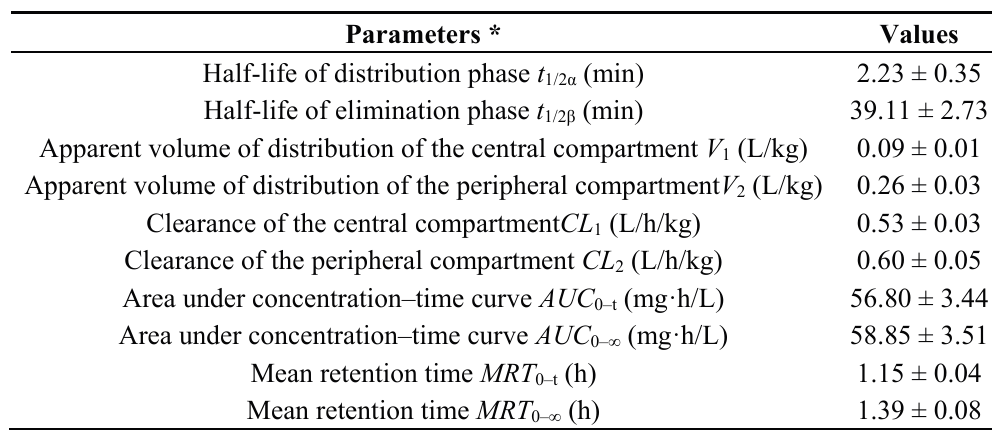
Table 3. Pharmacokinetics parameters of LPPF after a single intravenous (i.v.) administration at 40 mg/kg (mean ± SD, n =